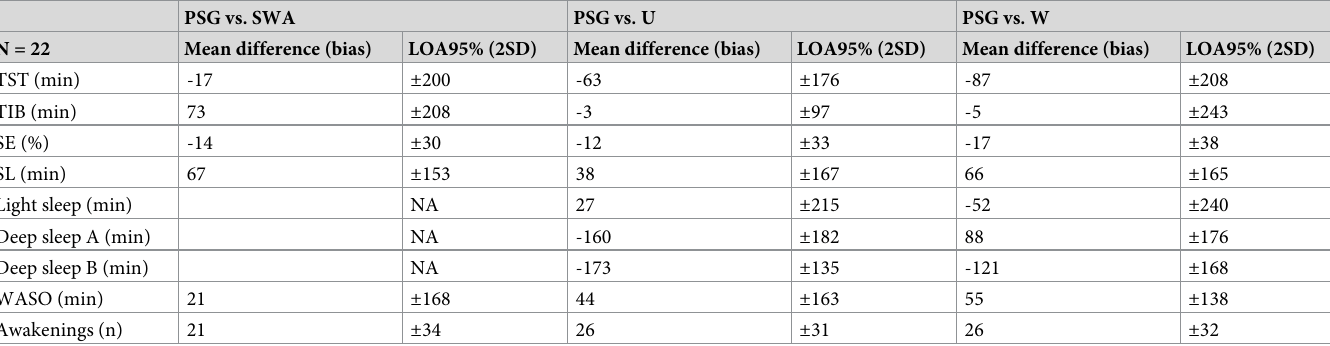
Table 3. Bland-Altman plot bias and limits of agreement results for sleep parameters for all devices. PSG vs.